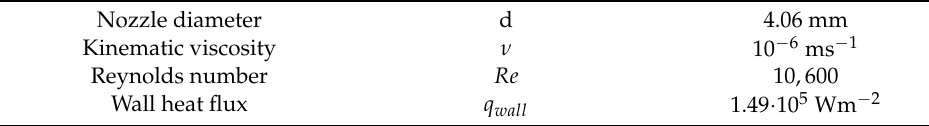
Figure 9. Computational domain of the impinging jet test case. Table 5. Impinging jet test case